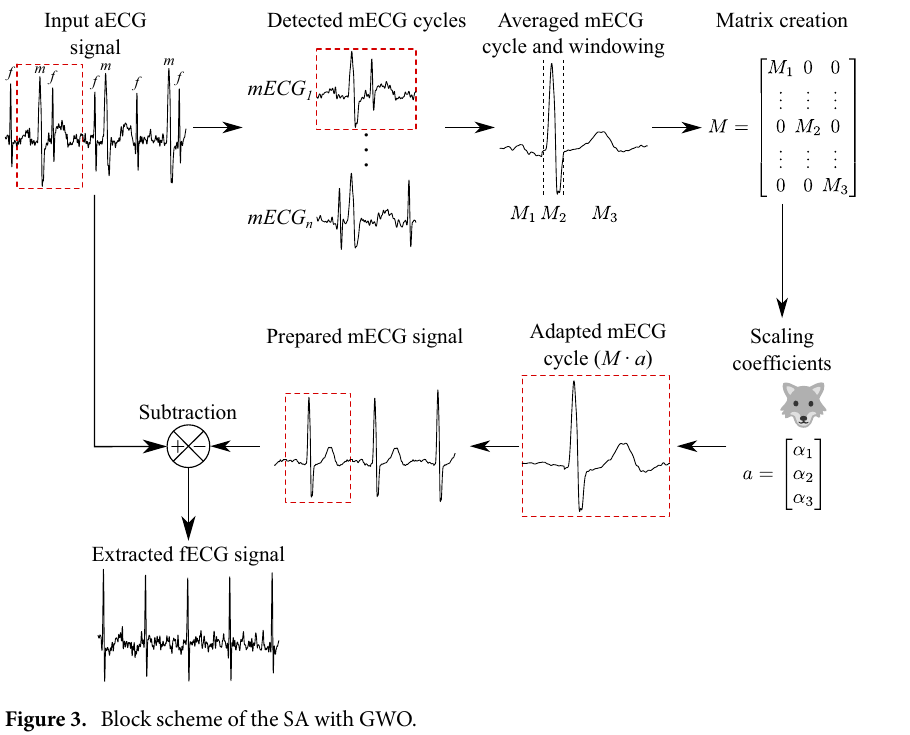
Figure 3. Block scheme of the SA with